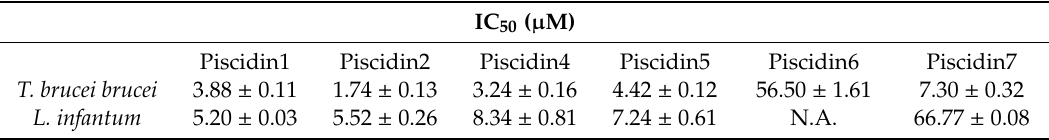
Table 4. Antiparasitic activity of sea bass synthetic